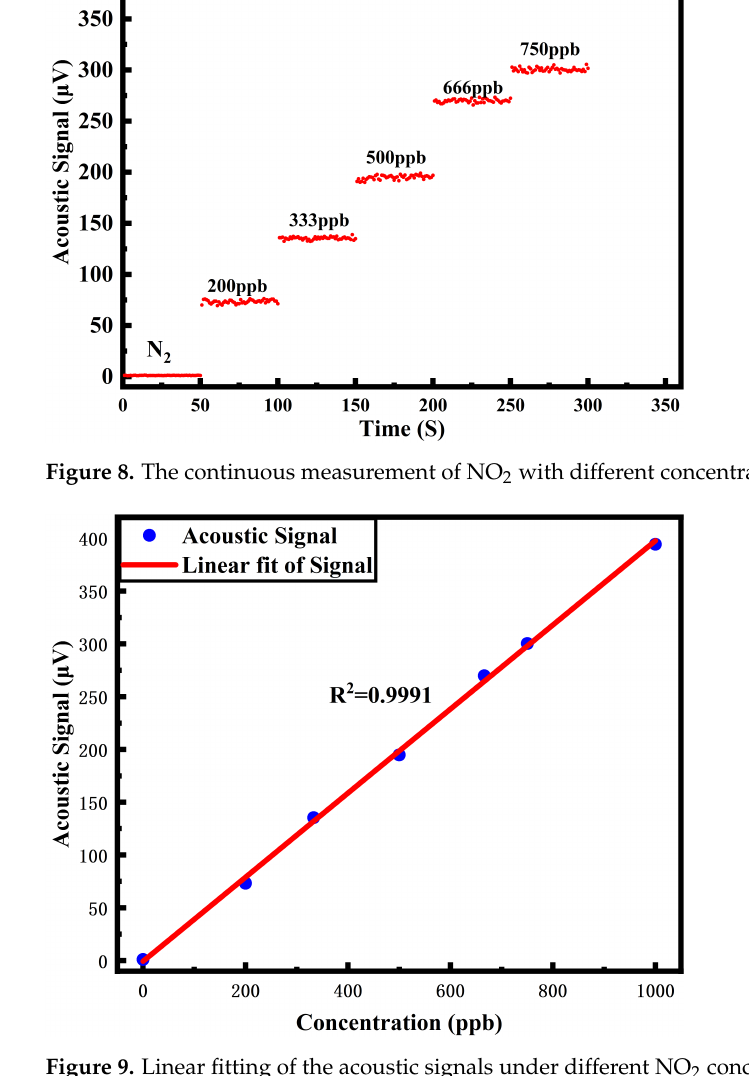
Figure 9. Linear fitting of the acoustic signals under different NO 2